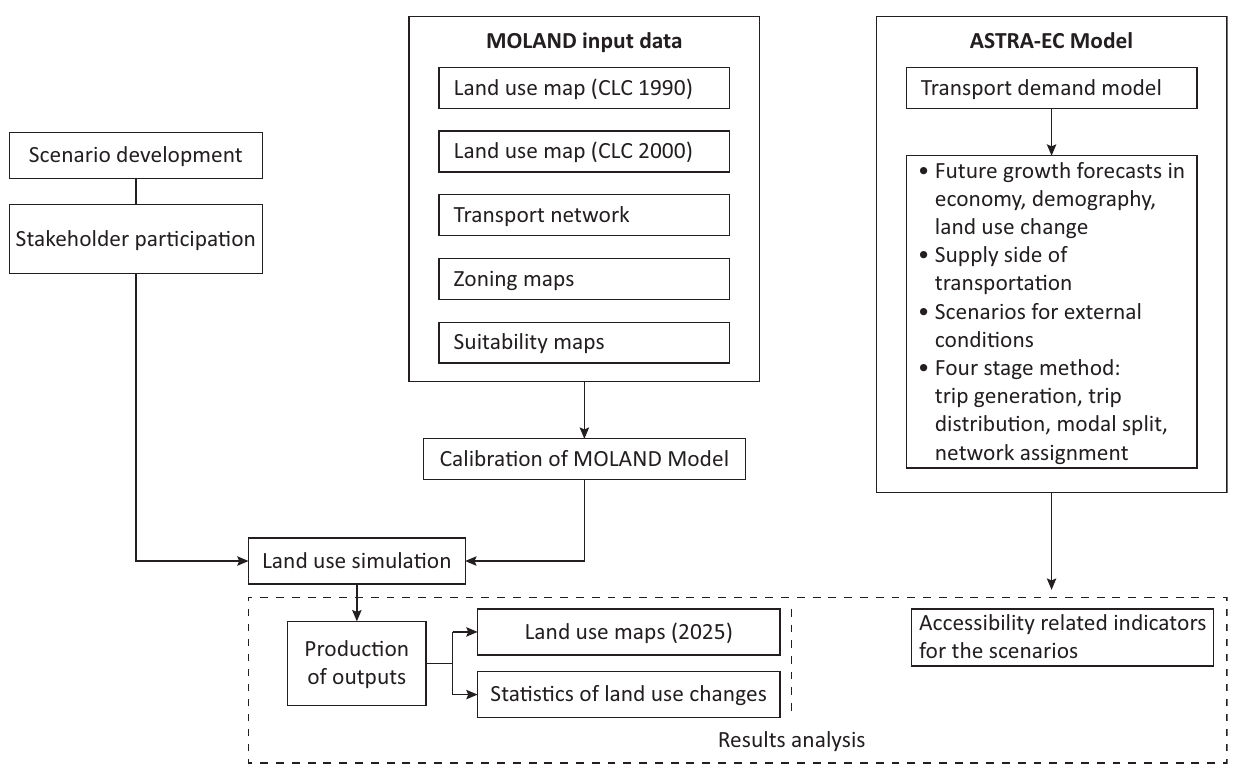
Figure 3. Land-use and transport modelling methodology. Adapted from Fermi, Fiorello, Krail and Schade (2014) and Lavalle et al.